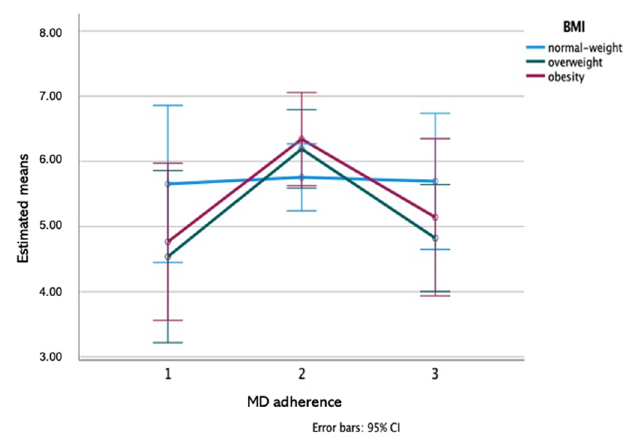
Figure 3. MD adherence * BMI interaction plot for salivary band K: a two-way ANOVA ( n = 122; MD adherence effect p = 0.005; Eta partial squared = 0.09; power of the test = 85%).